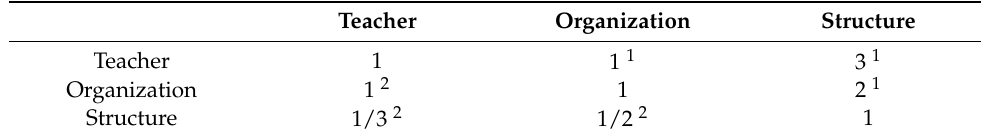
Table 4. Pairwise comparison matrices for parent criteria.